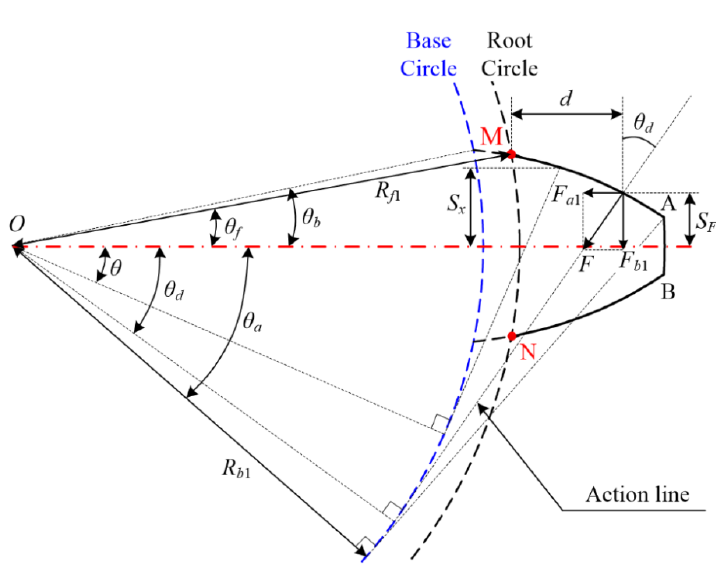
Figure 8. Equivalent model of the involute flexible wheel.